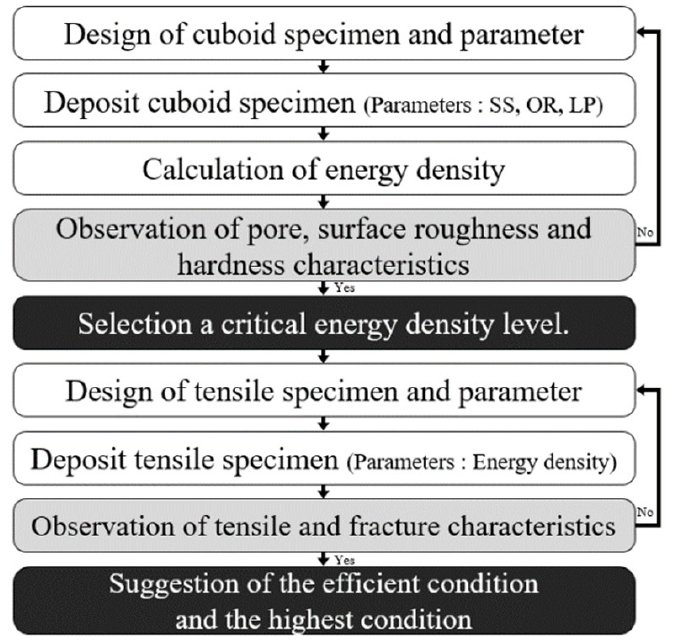
Figure 1. Flow chart of experiments.